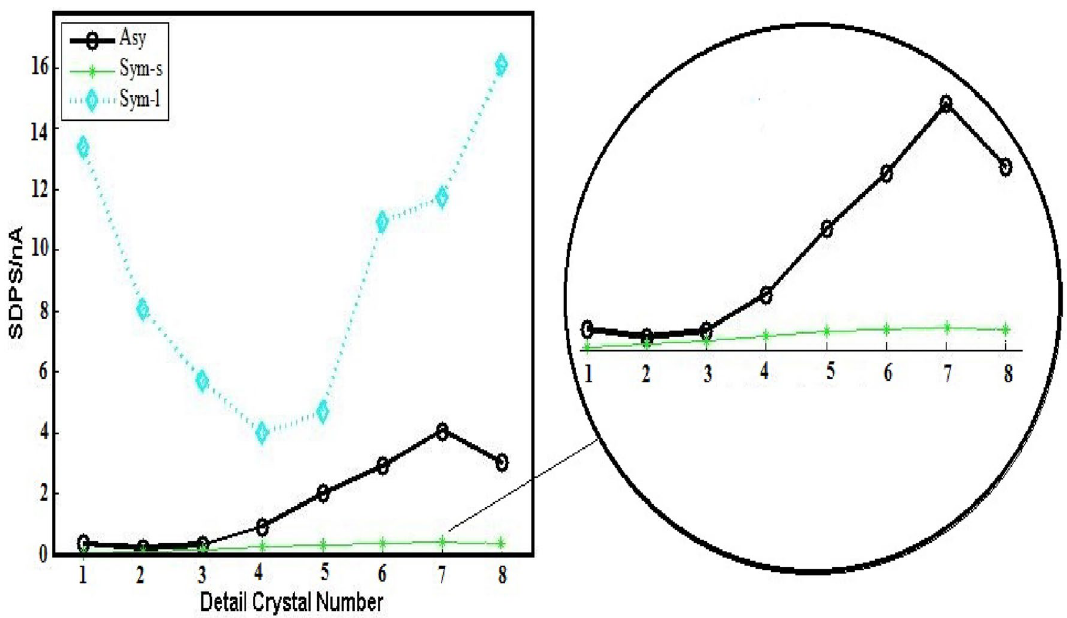
Figure 6. SDPS plots of Sym and Asy configuration ECN signals depicted in Fig.